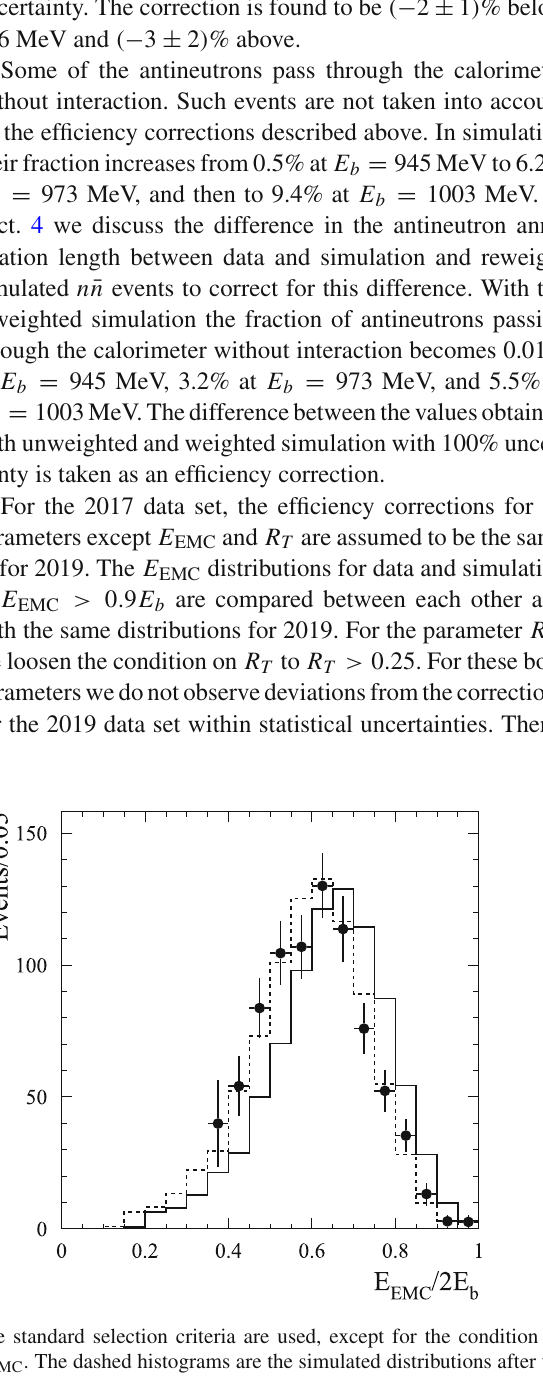
The standard selection criteria are used, except for the condition on E EMC . The dashed histograms are the simulated distributions after the transformations E EMC → 0 . 93 E EMC at the left plot, and E EMC → E EMC − 100MeV at the right